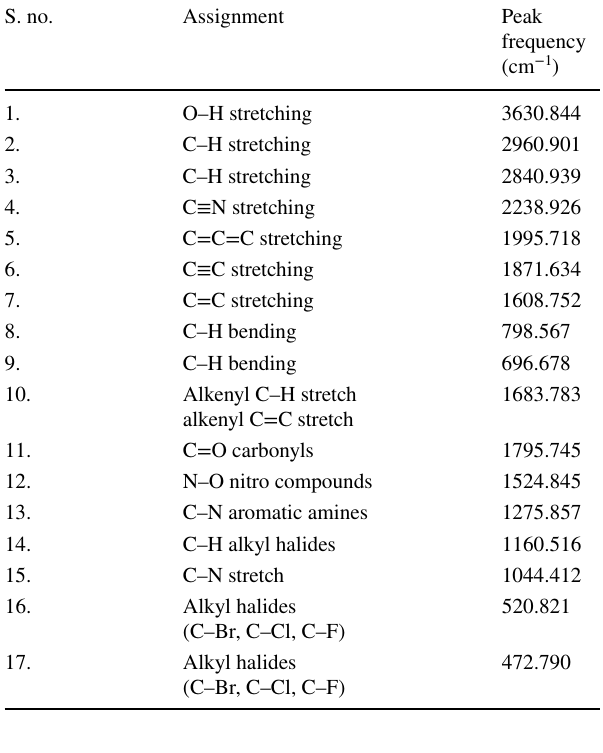
Table 3 Peak assignments in FTIR spectroscopy of samples S2, SK2, and SKC2